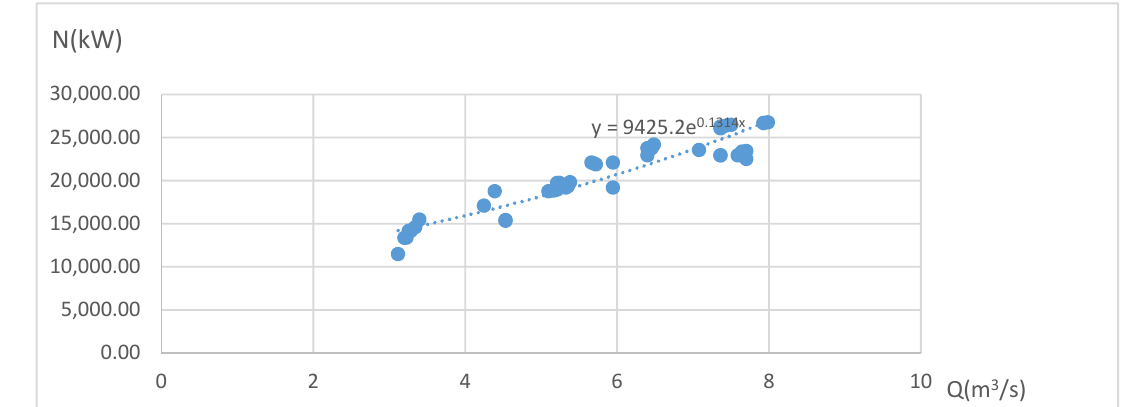
Figure 2. Unit dynamic characteristic NQ curve.